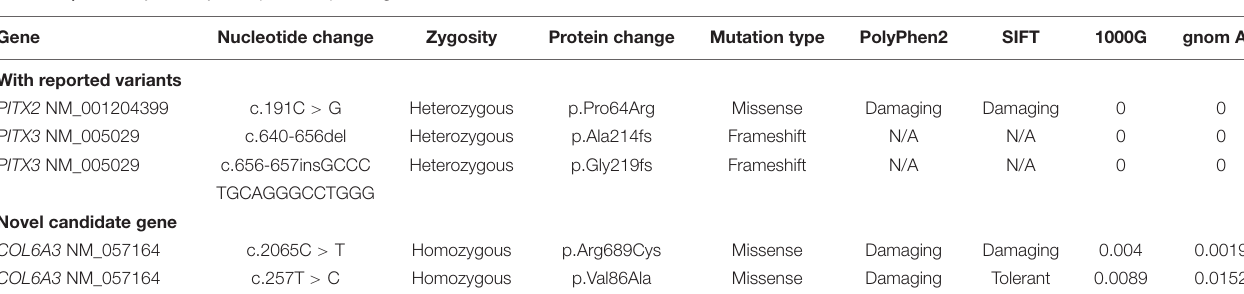
FIGURE 1 | COL6A3 was a novel candidate gene associated with type I Peters’ anomaly (PA). (A) Summary of the analysis of panel sequencing data for 23 patients with PA. Three reported variants in four patients, and one novel candidate gene were identified. (B) Photographs of corneas in the patient with type I PA. OD: oculus dexter (right eye), OS: oculus sinister (left eye). (C) Hematoxylin and eosin (HE)-stained corneal tissue sections; black arrows indicate the disordered lamellar arrangement with neoangiogenesis, and white arrows indicate the adhesion between cornea and iris. (D) Validation of the two novel homozygous mutations (NM_057164: c.2065C > T, p.Arg689Cys and c.257T > C, p.Val86Ala) by Sanger sequencing. (E) Conservation analysis on the two mutant residues across species. TABLE 2 | Summary of analysis of panel